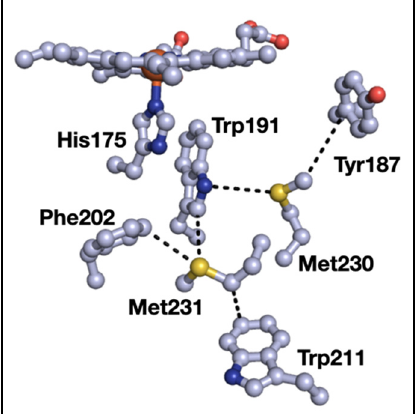
Figure 1. Examples of Met–aromatic interactions in yeast cytochrome c peroxidase (PDB ID 2CYP): Dashed lines indicate points of close contact and are for distance from 3.4 to 4.4 Å. Red = oxygen, blue = nitrogen, gray = carbon, yellow = sulfur. The backbone residues are omitted for clarity. The image was generated using PyMOL.